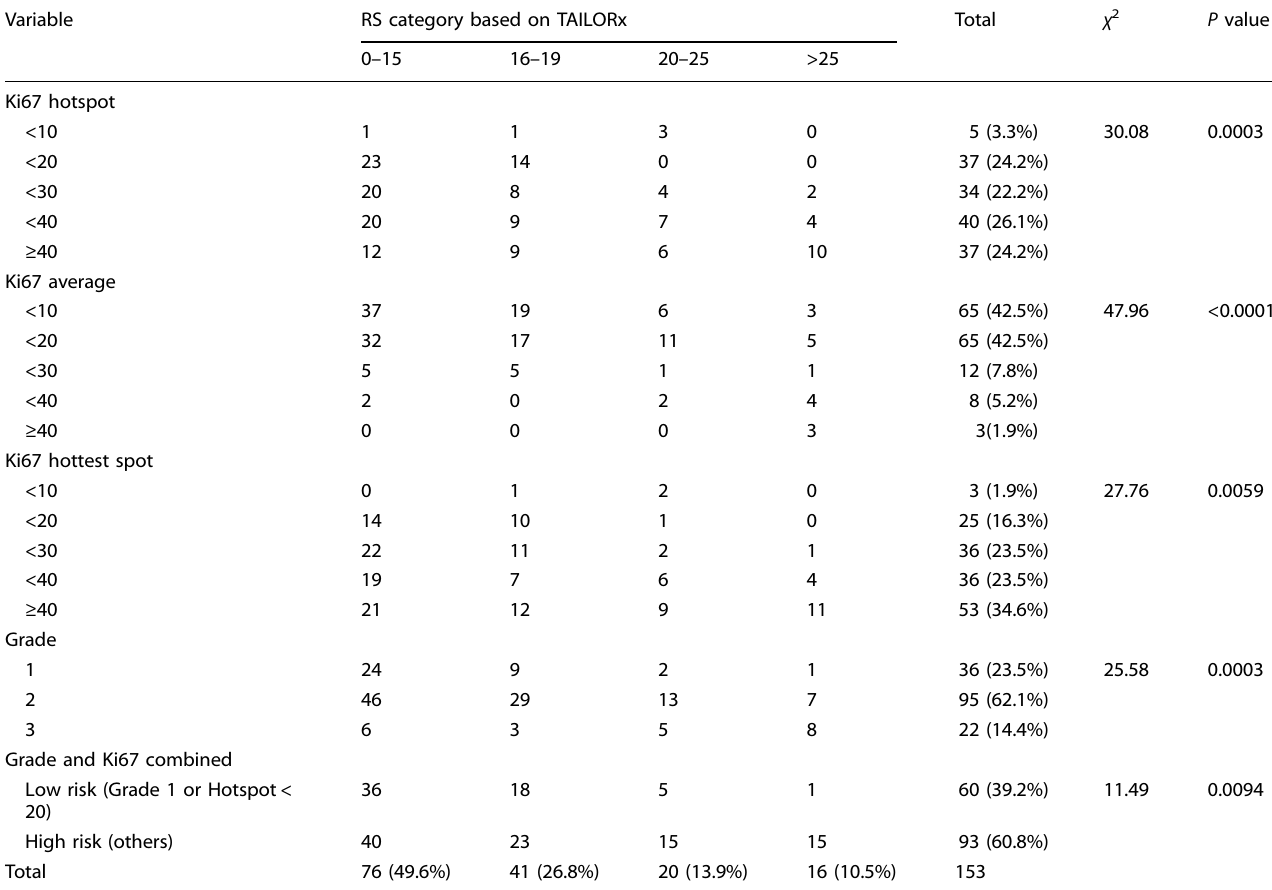
Table 1. Correlation between Ki67 labeling indexes/tumor grade and 21-gene recurrence score as categorical variables in women age < 50. Variable RS category based on